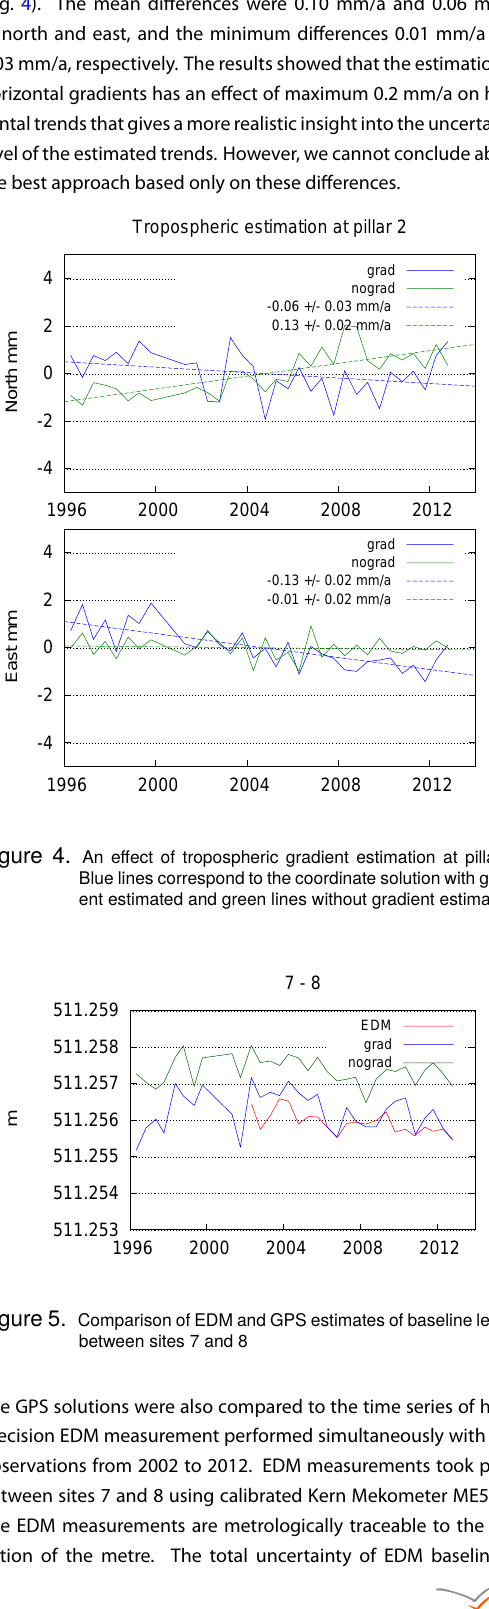
Figure 5. Comparison of EDM and GPS estimates of baseline length between sites 7 and